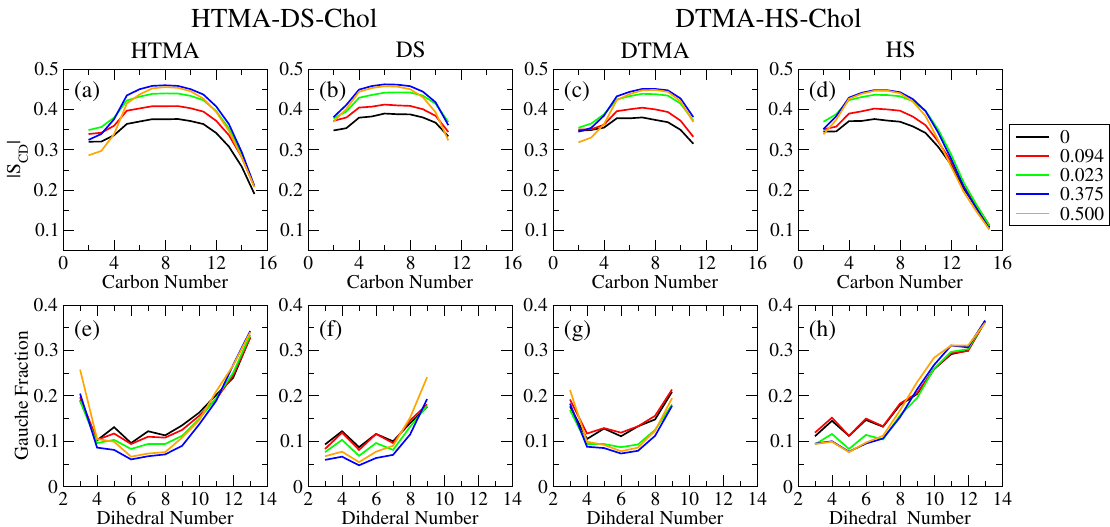
Figure 2. The deuterium order parameter ( | S CD | ) profiles at various X chol of ( a ) HTMA and ( b ) DS components for HTMA-DS-Chol systems and ( c ) DTMA and ( d ) HS components for DTMA-HS-Chol systems are shown in top panels. Also, the gauche fraction profiles at various X chol along the alkyl chains of ( e ) HTMA and ( f ) DS components for HTMA-DS-Chol systems and ( g ) DTMA and ( h ) HS components for DTMA-HS-Chol systems are shown in bottom